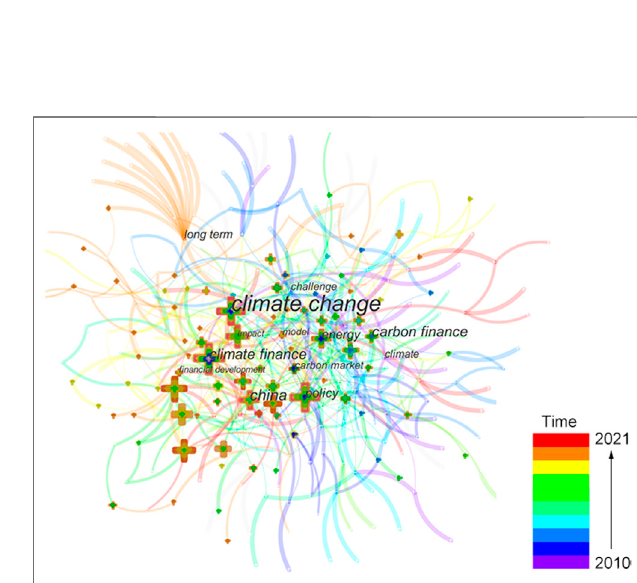
FIGURE 9 | Network of keywords by centrality. The links indicate the connections of related keywords, and the colours represent the dates of the connections. The size of the cross icon is proportional to the centrality of the keywords.